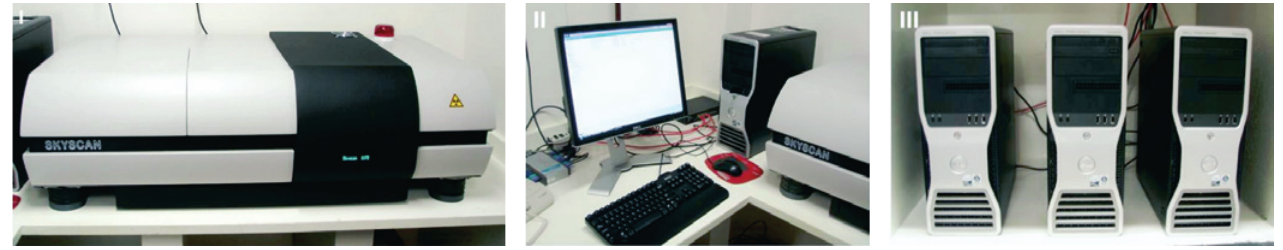
Figure 3 X-ray microtomography equipment, I – SkyScan 1172 Microtomography, II and III – Control and data acquisition